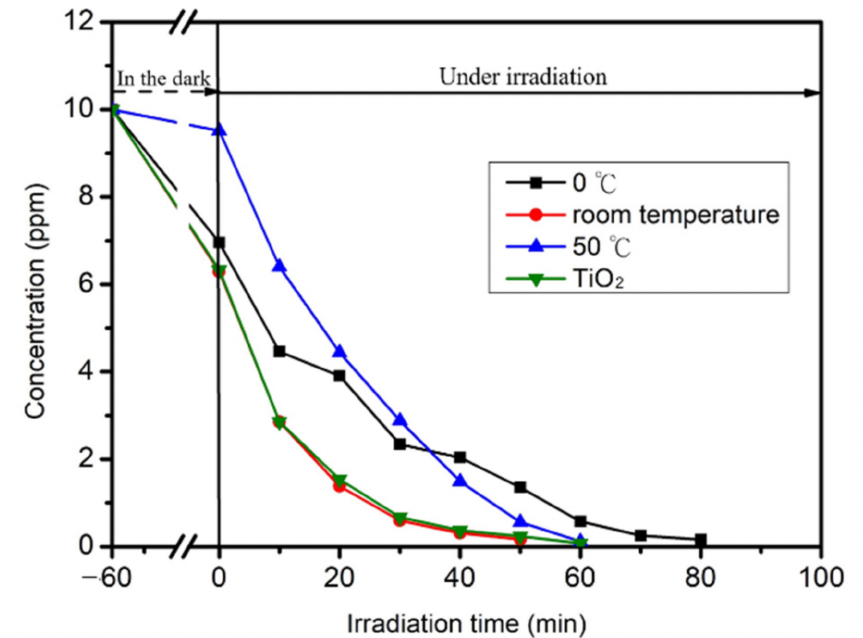
Figure 10. The change of the concentration of methylene blue on Cu/TiO 2 with time at different reaction temperatures.